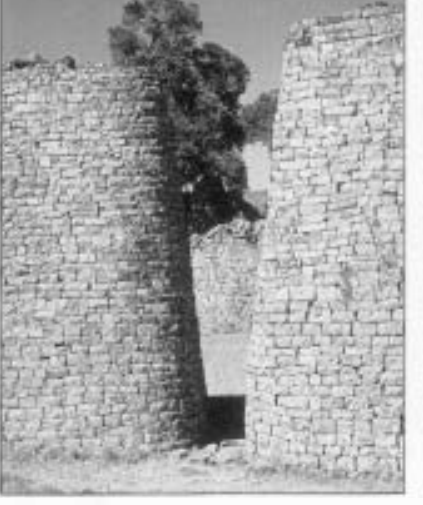
Figure 3 The northeast entrance to the elliptical building at Great Zimbabwe, Zimbabwe.